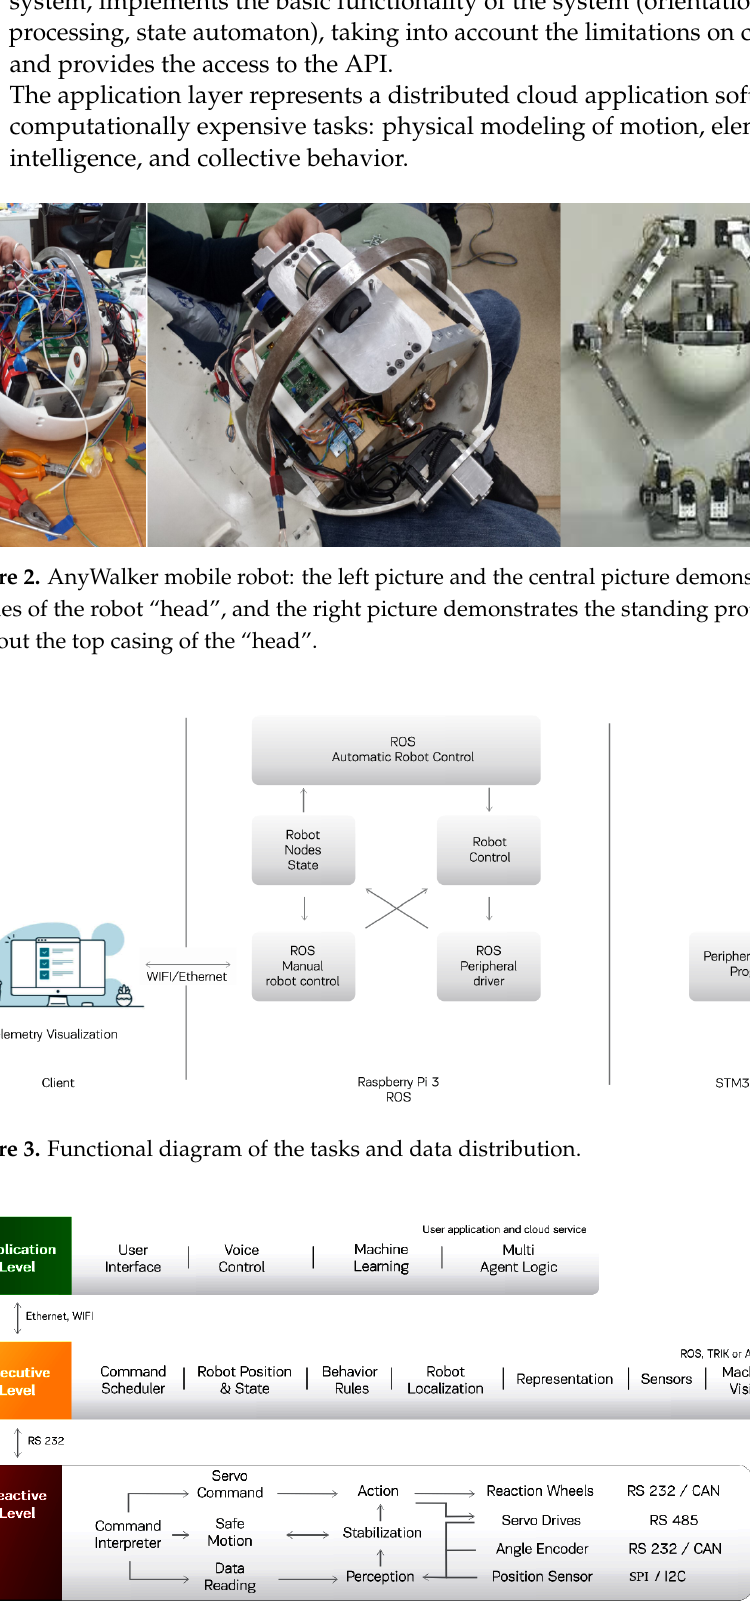
Figure 4. Three-level cloud control